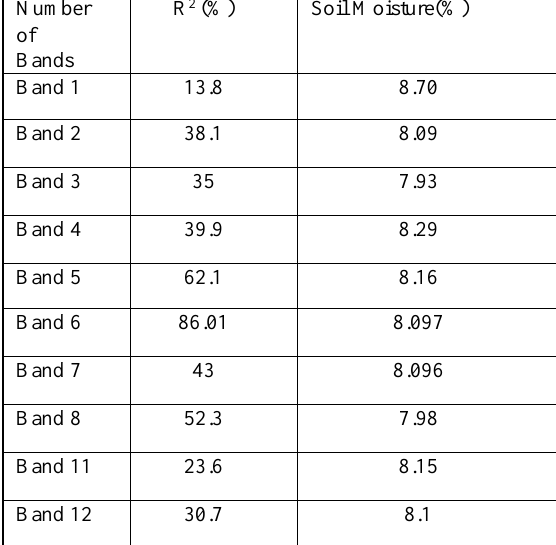
Table 1 . coefficient of determination for each band in Sentinel-2.